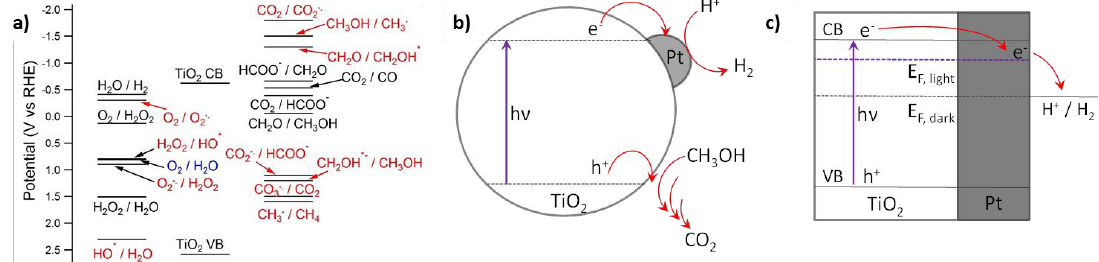
Figure 2. ( a ) Energy diagram showing the conduction and valence band potentials of TiO 2 anatase, C1 and water-related redox couples at pH 7 and 298 K [10–13] Monoelectronic couples are in red, bielectronic in black, the four-electron couple O 2 /H 2 O is in blue. ( b ) Simplified pictorial scheme of the methanol reforming on a irradiated Pt/TiO 2 particle. ( c ) Photoinduced charge separation and charge distribution in Pt/TiO 2 nanocomposites. E F, dark and E F, light represent the pseudo-Fermi levels in the dark and under irradiation, respectively. Adapted with permission from [14]. Copyright 1979 American Chemical Society.